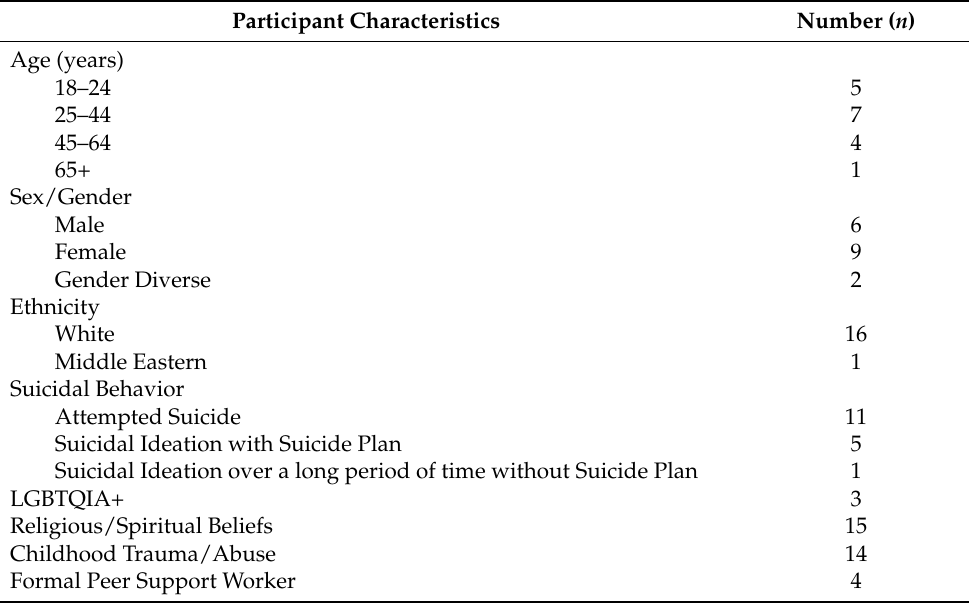
Table 1. Sociodemographic characteristics of participants ( N =